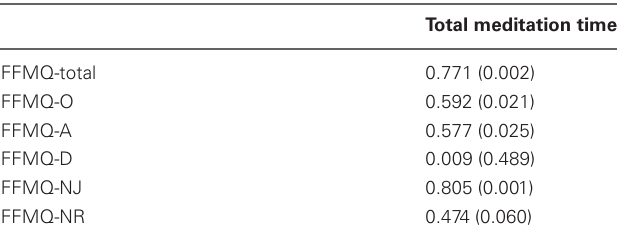
Table 2 | Pearson coefficients for the correlations between total amount of time spent meditating between T1 and T3 and increase in mindfulness (FFMQ scores) from T1 to